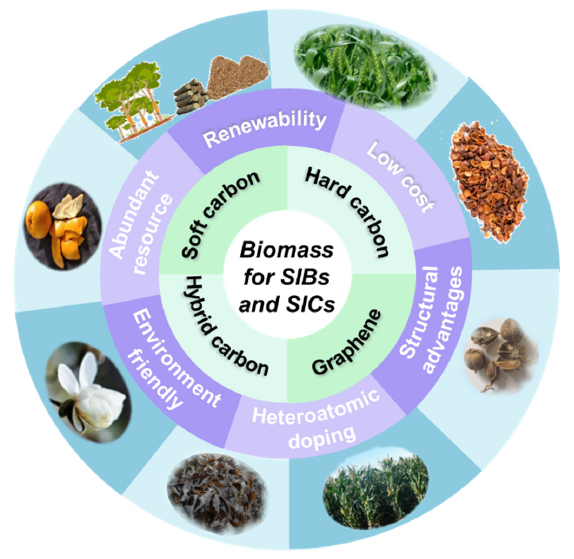
Figure 1. The schematic diagram of biomass-based electrode materials from different precursors, and their inherent advantages. Table 1. Physical and electrochemical properties of various carbons.